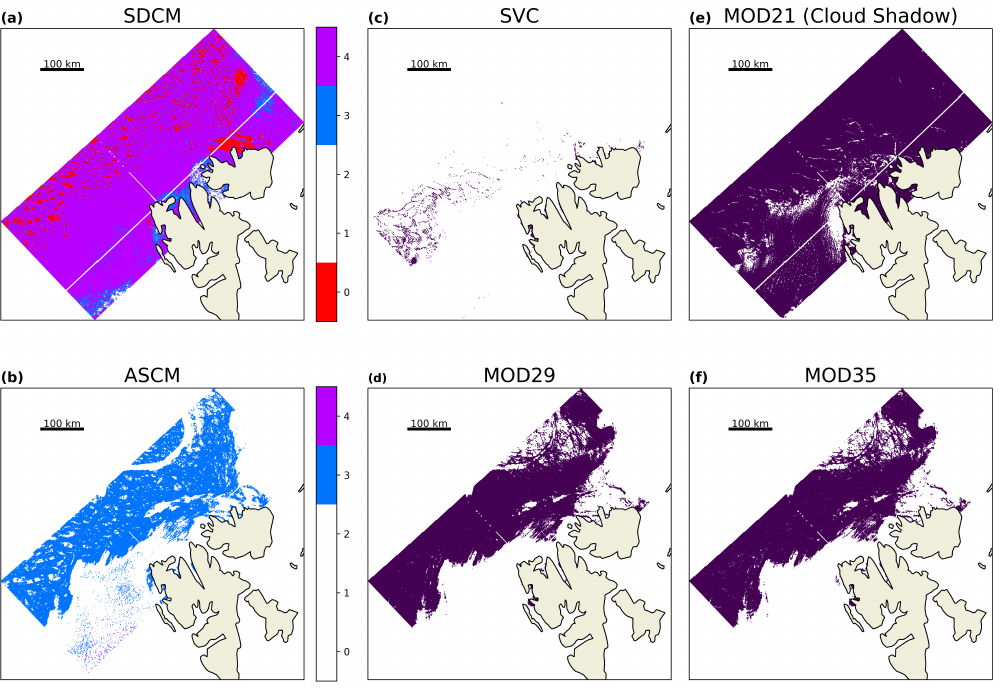
Figure 2. An illustration of the different cloud masks ( a ) SDCM, ( b ) ASCM, ( c ) SVC, ( d ) MOD29, ( e ) MODIS-derived cloud shadow mask after [41], ( f ) MOD35; for Orbit O054627 Blocks 20–23 around Svalbard. Pixels designated as cloud free from each mask are displayed; however, only ( c ) and ( d ) actually implement a sea-ice classifier. For ( a ): 4 = Near Surface High Confidence, 3 = Near Surface Low Confidence, 2 = Cloud Low Confidence, 1 = Cloud High Confidence, 0 = No Retrieval (considered clear); ( b ): 4 = Clear High Confidence, 3 = Clear Low Confidence, 2 = Cloud Low Confidence, 1 = Cloud High Confidence, 0 = No Retrieval (considered cloud). In all cases, magenta denotes a high-confidence positive (considered cloud-free) retrieval, blue a low-confidence positive retrieval, purple a positive retrieval with no associated confidence interval presented, and red no retrieval considered positive. WGS 84 / NSIDC EASE-Grid 2.0 North. Generated using Cartopy and